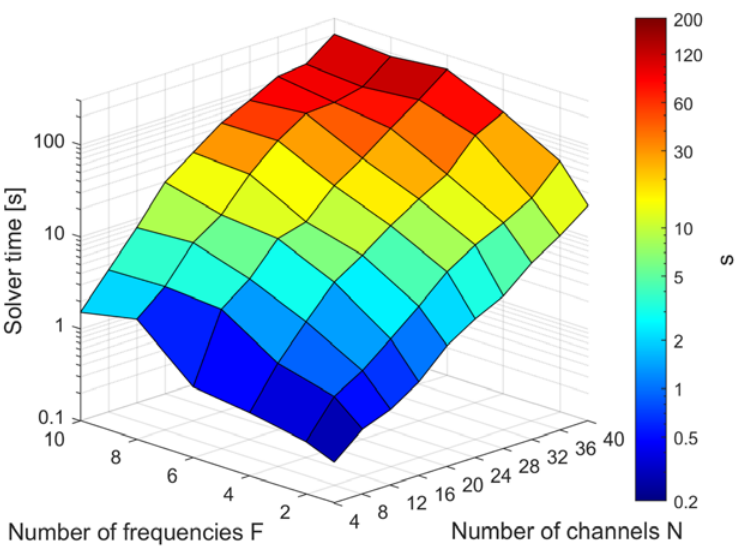
Figure 8. Runtime dependence on the number of available RF channels and frequencies used during the optimization. Since performance varied from the sub-second range up to about three minutes for the most complex scenario, a logarithmic scale was used. All calculations were performed by the iterative algorithm using the single-tumor model with 257 target points and approximately 30,000 total constraint voxels. For typical clinical problem sizes (single frequency, maximum of 20 channels during the planning stage [34]), the optimization times stayed below 2.5 s. The largest problem with all 40 channels and 10 frequencies was completed in 3 min and 24 s.